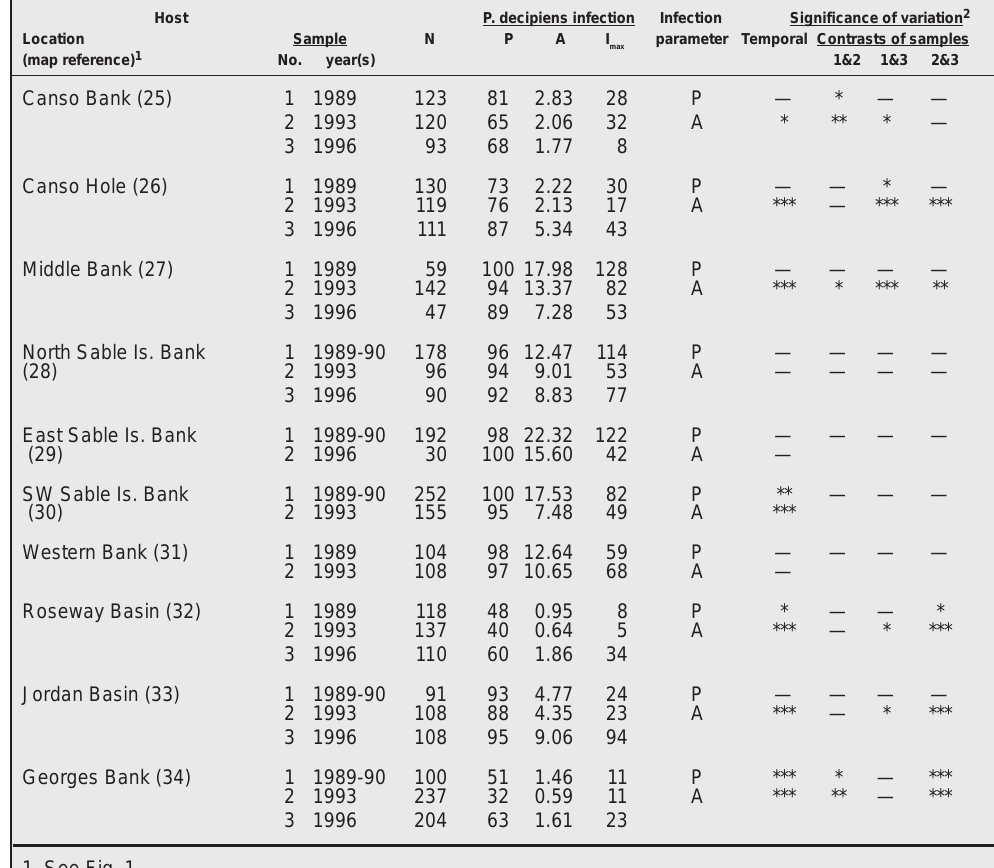
Table 3. Prevalence (P), abundance (A) and maximum intensity (I infection in Hippoglossoides platessoides , 31-40 cm in length, from the central and southwestern Scotian Shelf, and the Gulf of Maine, with temporal contrasts of prevalence and